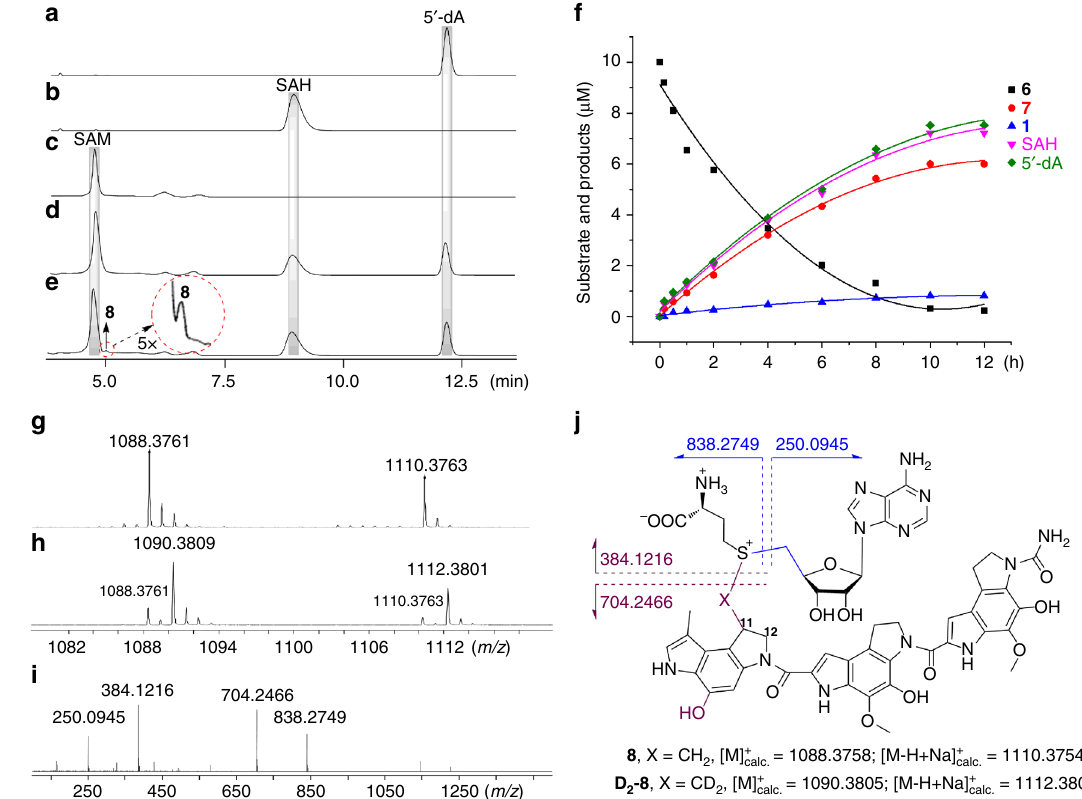
Fig. 3 Analysis of reaction products from the cyclopropanation process. a – e HPLC analysis of the enzymatic products (UV at 260 nm). a Standard of 5 ′ -dA. b Standard of SAH. c The control reaction using boiling-inactivated enzymes. d , e are the concentrated products from a large-scale enzymatic assay terminated at 4 h and subjected to evaporation and lyophilization, respectively. f Time-course analysis of the concentration changes of 1 , 6 , 7 , 5 ′ -dA, and SAH from the cyclopropanation process. g , h are the HR-MS analyses of the intermediate 8 from the reactions using SAM and CD 3 -SAM, respectively. i MS/MS analysis of 8 using SAM. j The chemical structure and calculated molecular weight of the intermediate